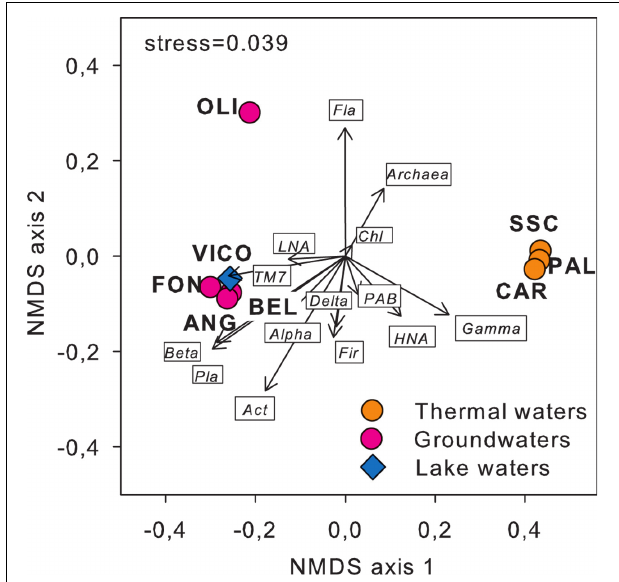
FIGURE 3 | Cell abundance variation of the major prokaryotic subgroups, including flow cytometry (LNA and HNA cells) and CARD-FISH data (i.e., major phyla and classes of Proteobacteria ), projected onto the NMDS ordination synthesizing the chemical dissimilarity between thermal and non-thermal waters (see Figure 1 ). The vector length is proportional to the correlation between the NMDS axes and each microbial variable, upon normalization by log(X+1). Act , Actinobacteria ; Chl , Chloroflexi ; Fir , Firmicutes ; Fla , Flavobacteria ; Pla , Planctomycetes ; Alpha , Alphaproteobacteria ; Beta , Betaproteobacteria ; Gamma , Gammaproteobacteria ; Delta , Deltaproteobacteria ; LNA, low nucleic acid content cells; HNA, high nucleic acid content cells; PAB, prokaryotic